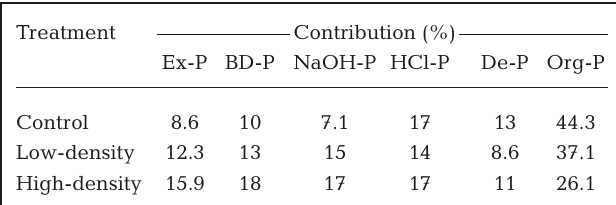
Table 1. Contribution of each phosphorus (P) fraction to sediment total P in the Tegillarca granosa treatments. BD-P: redox-sensi- tive P; De-P: detrital P; Ex-P: exchangeable or loosely sorbed P; HCl-P: calcium-bound P; NaOH-P: metal oxide-bound P;